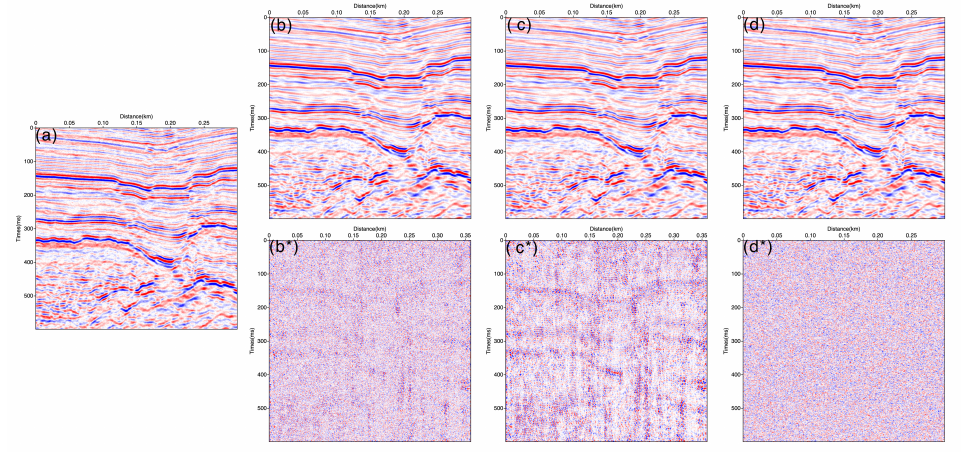
Figure 8. The comparison of three methods’ denoised results in real seismic data. ( a ) The field desert post-stack seismic data. ( b , b* ) Denoised result and removed noise profile using APF method. ( c , c* ) Denoised result and removed noise profile using DnCNN. ( d , d* ) Denoised result and removed noise profile using FACNN.